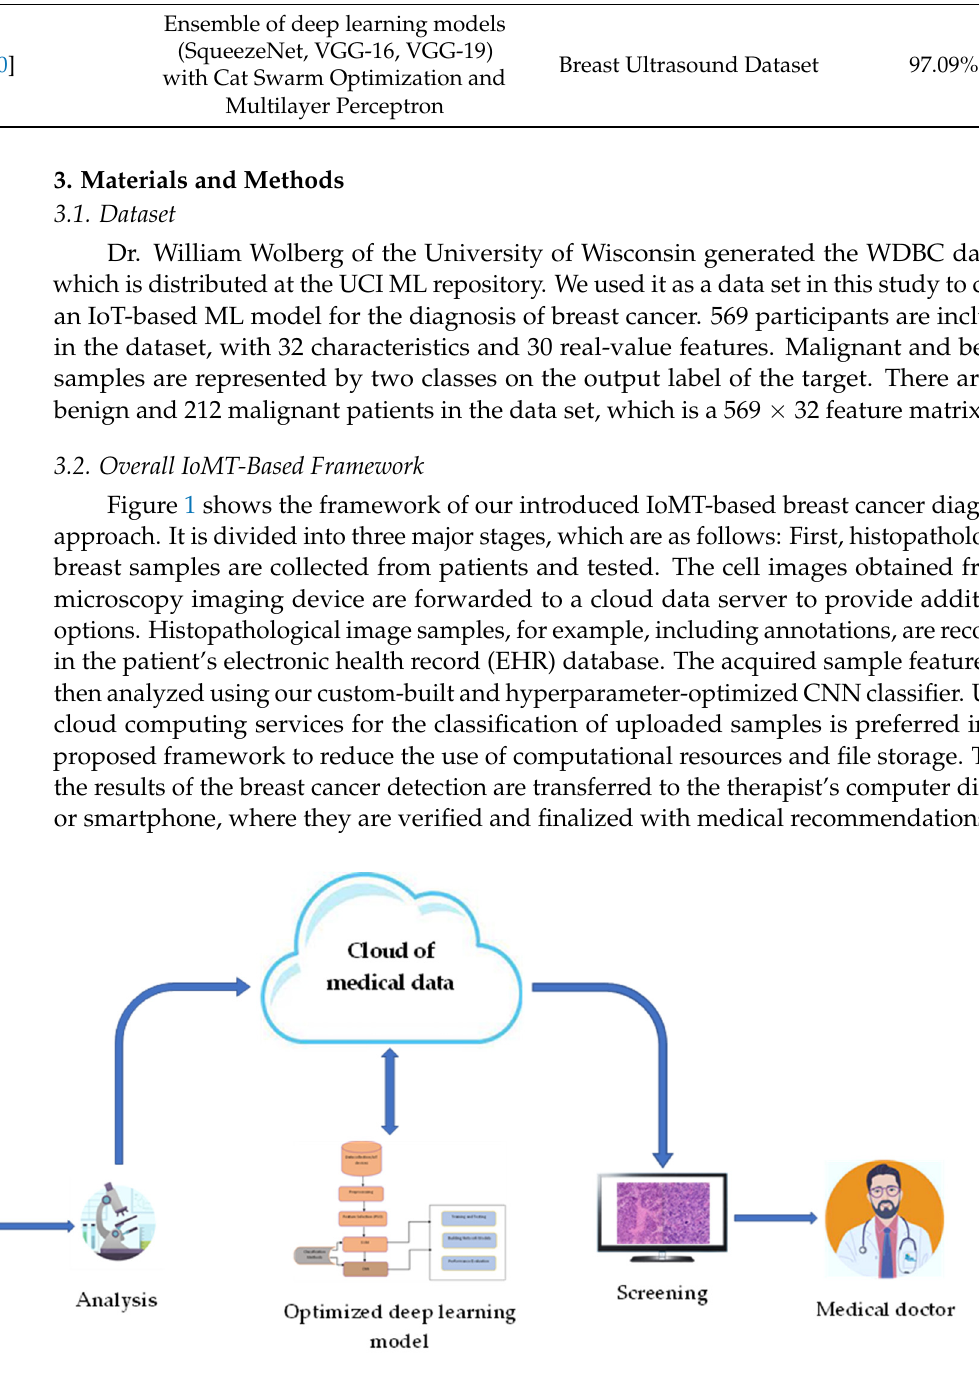
Figure 1. Schematic architectural diagram of the proposed medical IoT-based breast cancer diagnosis framework for automatic identification of breast cancer using the proposed hyperparameter optimized CNN classifier.